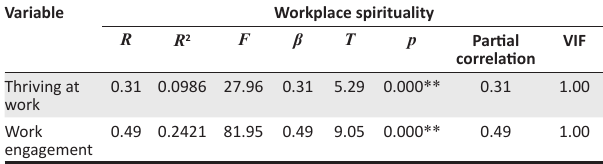
independent variable, and thriving at work and work engagement are the dependent